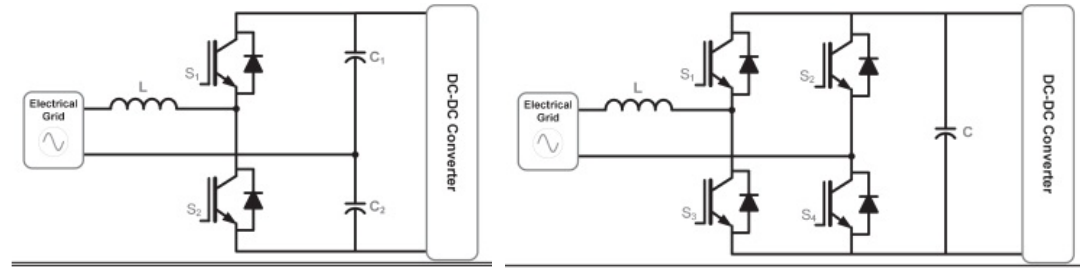
Figure 11. Bi-directional half-bridge and full-bridge controlled converter.